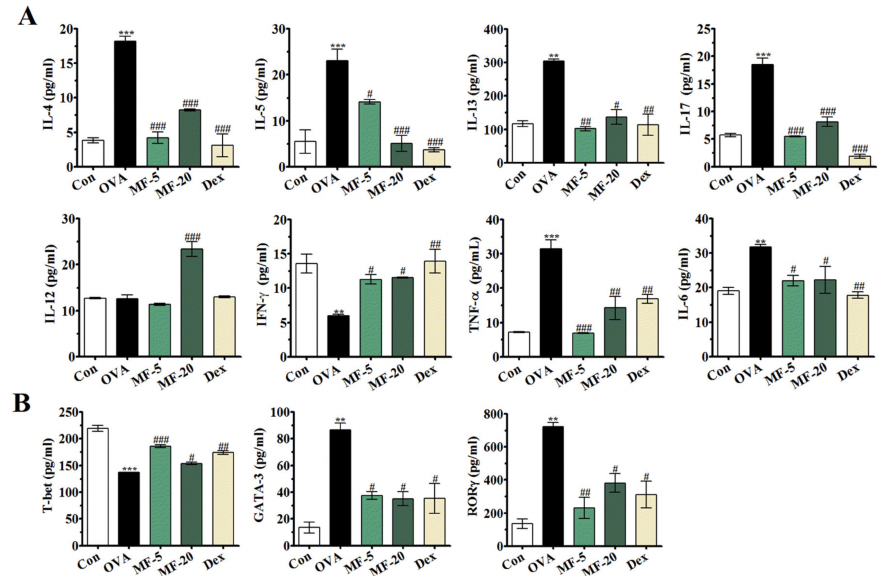
Figure 5. E ff ect of MF on Th1 / Th2 / Th17 and pro-inflammatory cytokines and related transcription factor in OVA-induced AR mice. The levels of ( A ), Th2 cytokines, IL-4, IL-5, IL-13; Th17 cytokine, IL-17; Th1 cytokines IL-12, IFN- γ and pro-inflammatory cytokines TNF- α and IL-6 were determined in NALF. ( B ) Analysis of T-bet, GATA-3 and ROR γ expression levels in NALF. Values are presented as the mean ± SEMs ( n = 6 per group). ** p < 0.01 , *** p < 0.001 , significantly di ff erent from the value of Control